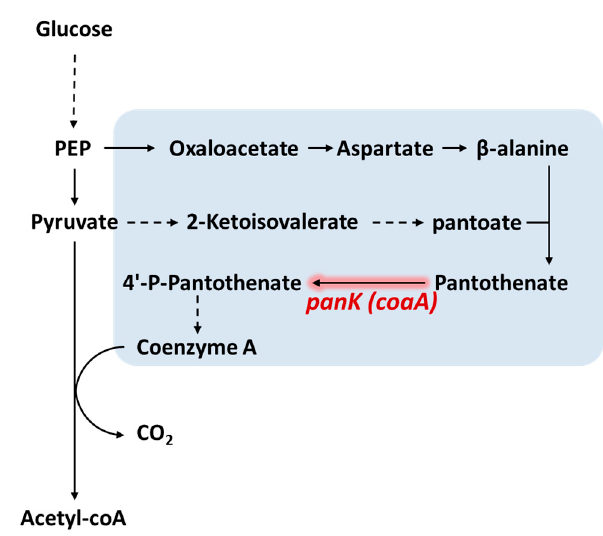
Figure 4. Scheme of coenzyme A synthesis. The coenzyme A synthesis pathway is shadowed in blue. panK (also named as coaA ) was the committed step for coenzyme synthesis, which is proposed to be expressed to increase both coenzyme A and acetyl-CoA concentration. Dashed arrows indicate multi-step reactions. Abbreviation: PEP, phosphoenolpyruvate.